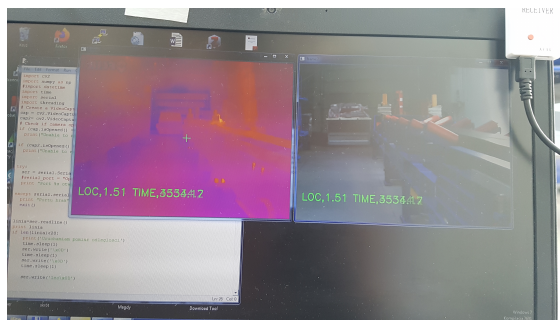
Figure 18. Robot in action—A view on a laptop